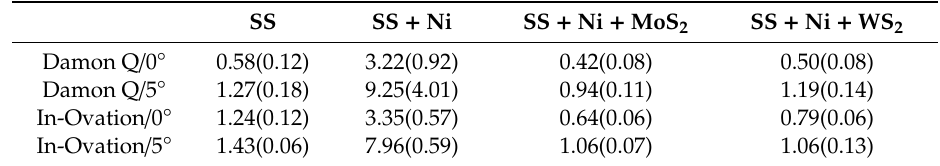
Table 2. Mean and standard deviation of five measurements of the frictional force in dry condition.